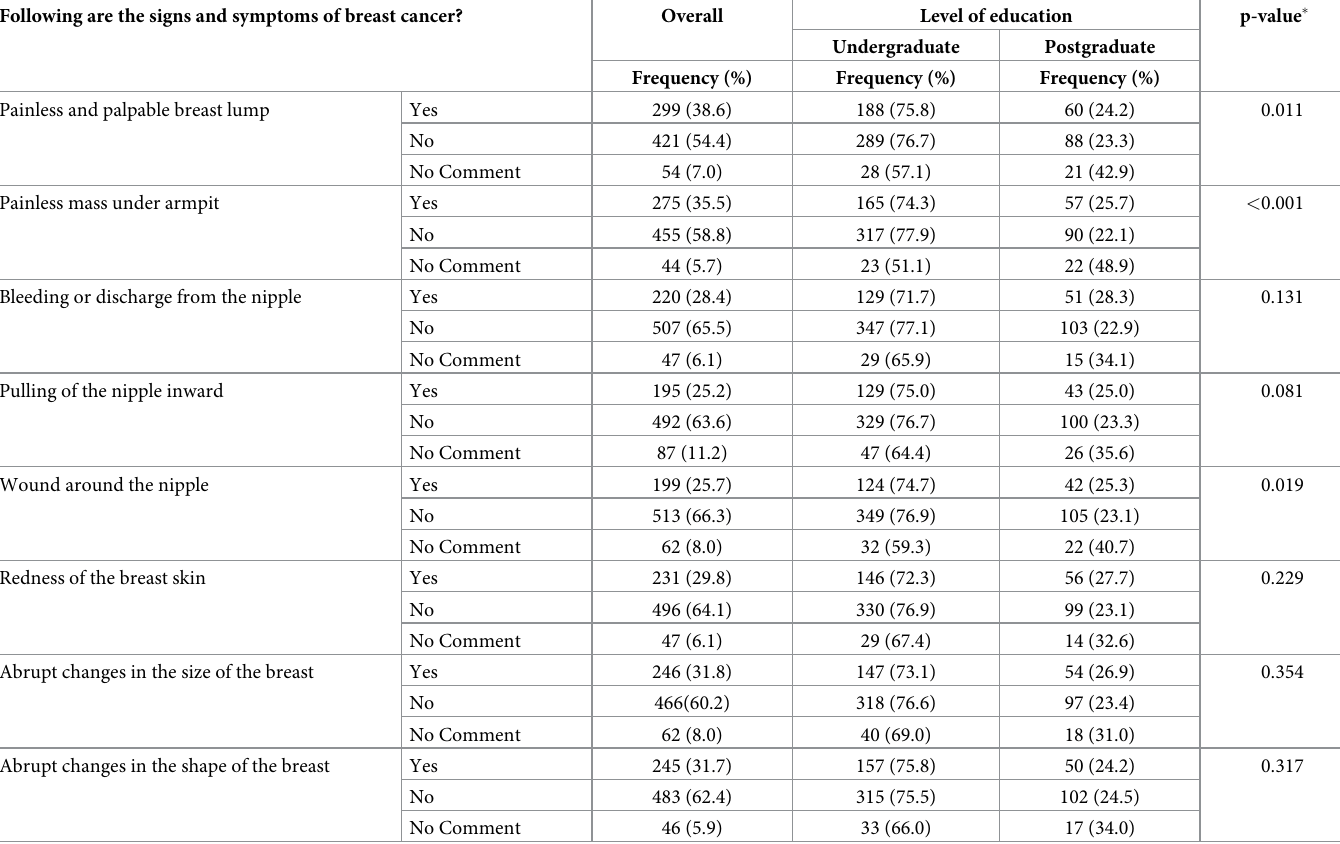
Table 5. Participants knowledge of breast cancer signs and